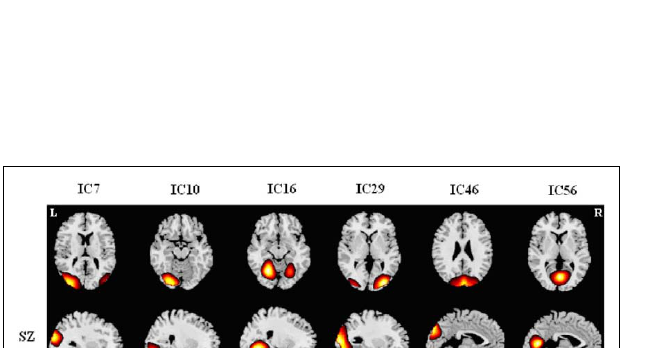
FIGUREA5 | Spatial maps of components in moduleV for HCs (upper) and SZs (lower). Hubs of this module in each group are labeled. Each column shows one component in axial, sagittal, and coronal views.There are eight common components (in the box) including three temporal components, four sensory motor components, and one parietal component. HCs have another nine components including two cerebellar components, three occipital components, one temporal component, one central